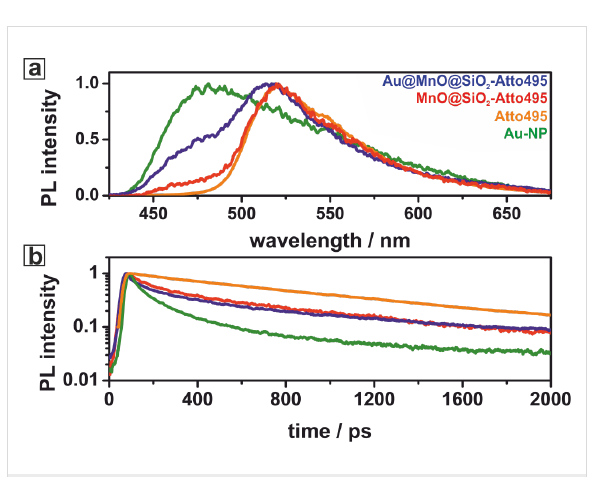
Figure 17: (a) Time-resolved fluorescence spectra of Au nanoparti- cles (green), Atto495 (orange), MnO@SiO 2 (red), and Au@MnO@SiO 2 -Atto495 (blue) after excitation at λ = 400 nm by a 100 fs pulse indicating the absence of electron transfer between Au and MnO respectively Atto495 encapsulated within the SiO 2 shell; (b) respective photoluminescence dynamics tracked at 500–550